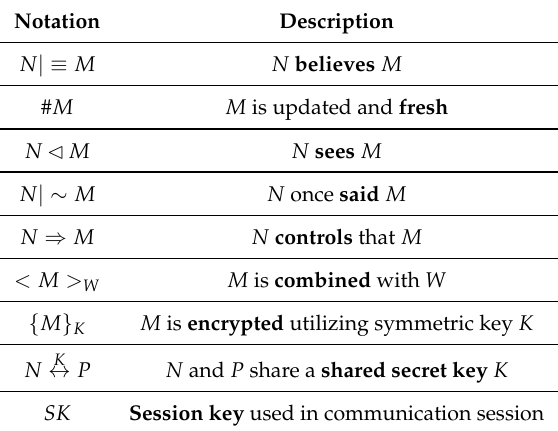
Table 3. Notations used for BAN